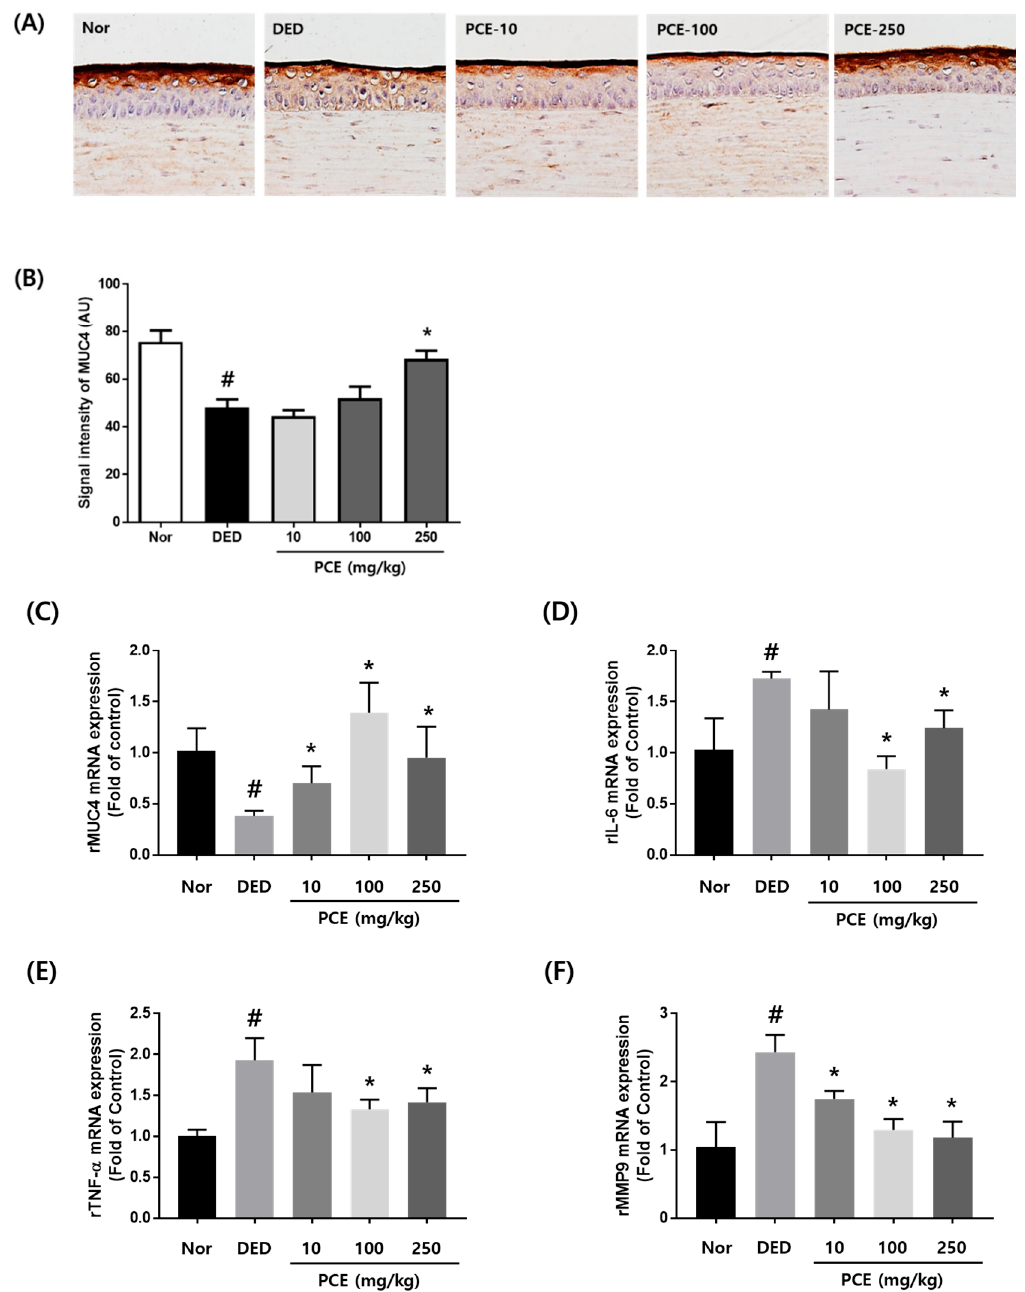
Figure 4. Effects of P. cuspidatum (PCE) on expression of mucin 4 (MUC4) and inflammatory cytokines in exorbital lacrimal gland-excised rats. ( A ) Immunohistochemical staining for Muc4. ( B ) Morphometric analysis of Muc4-positive signal density in corneal sections from each group. The values in the bar graph represent the mean ± SEM, n = 10. RNA was extracted from the corneal tissue of exorbital lacrimal gland-excised rats. mRNA levels of ( C ) MUC4 , (D) IL-6 , ( E ) TNF- α , and ( F ) MMP9 were assessed by real-time PCR assay. GAPDH was considered an internal control. Data are the mean ± SEM of three independent experiments for all groups. # p < 0.05, significantly different from normal mice, * p < 0.05, significantly different from vehicle-treated dry eye mice.